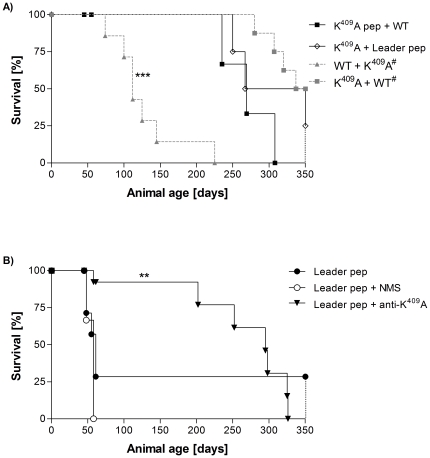
The neutralizing potential of previous inoculation of K409A molecule and anti-K409A antibodies on SLE suppression.A) Combined effect of K409A and WT in survival time. Forty-five-day-old female [NZBxNZW]F1 mice [n = 4 to 6/group] were inoculated with K409A pep or K409A, and after 7 days received WT rHsp65 [K409A pep+WT group: ▪] or Leader pep [K409A+Leader pep group: ◊]. #Data from [16]. ***p<0.001: K409A pep+WT and K409A+Leader pep versus WT+K409A group. B) Survival analysis of [NZBxNZW]F1 45-day-old mice [n = 4 to 7/group] inoculated with Leader pep [•]; Leader pep incubated with HIII normal mice sera [○]; or Leader pep incubated with HIII K409A-immunized mice [▾]. Leader pep group was the reference group for unpaired t-test analysis; **p<0.01. Results are representative of 2 independent experiments.